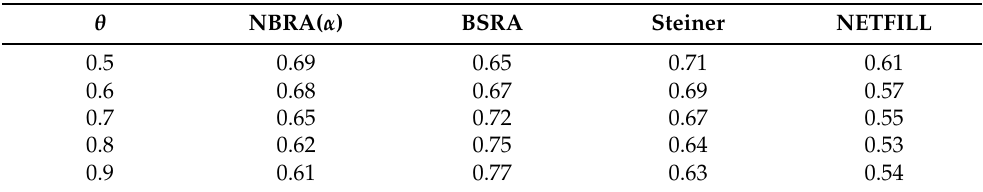
Table 2. Recovery probabilities of four algorithms: (i) NBRA( α ), (ii) BSRA, (iii) Steiner, and (iv) NETFILL as varying the observation probability θ .